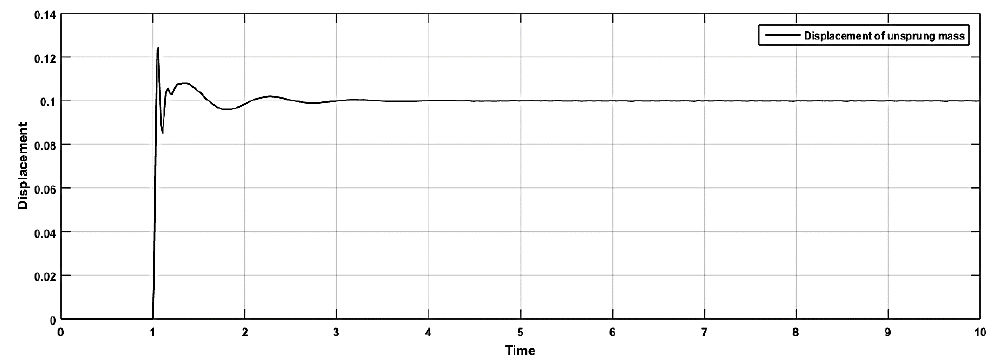
Figure 12. Displacement of the unsprung